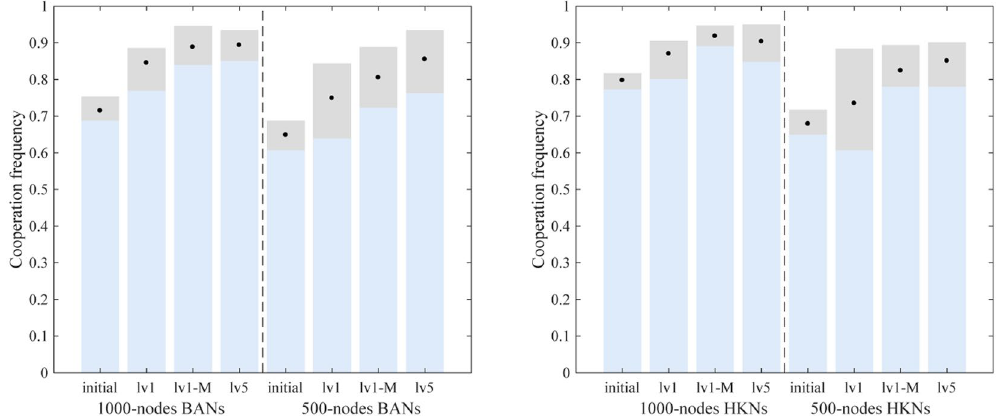
Figure 4. Simulation results of lv1, lv5 and lv1-M in optimizing population structure for the promotion of cooperation in PDG. Each group contains 10 independent structures whose evaluated cooperation level lies within a gray bar (black points mark the mean value). On the whole, these algorithms all efficiently promote cooperation in PDG, and the performance of mlEA-C PD -SFN 5 surpasses those of the others.